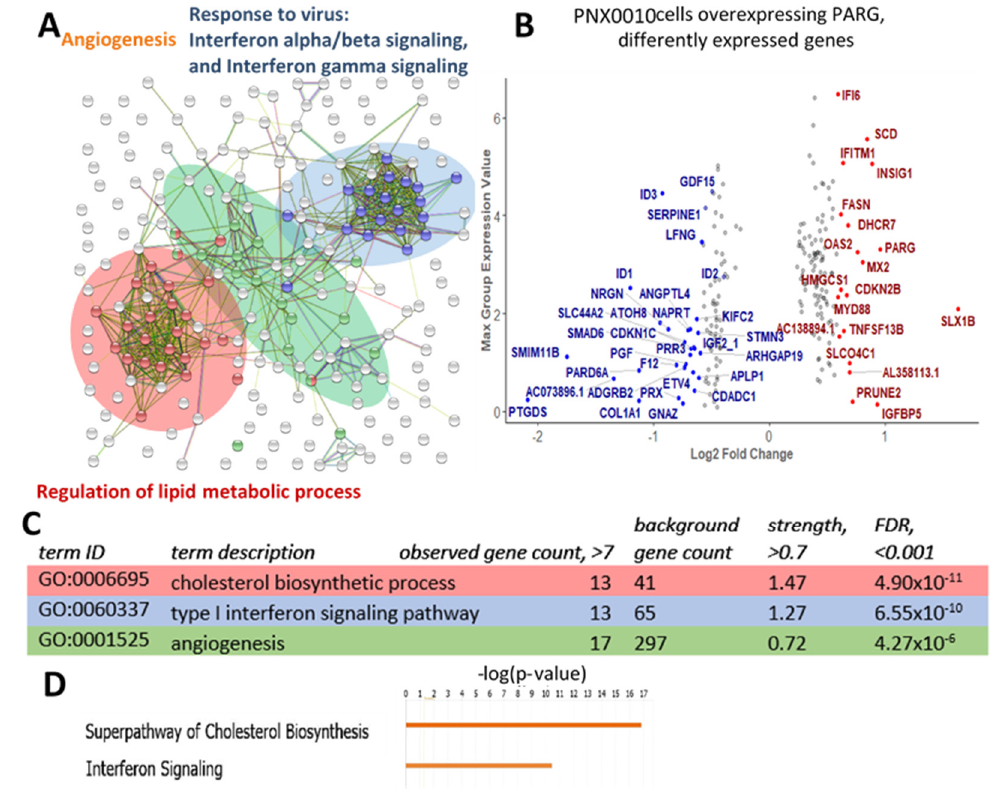
Figure 4. Lipid biosynthesis, interferon signaling, angiogenesis pathways, and several cancer-driving genes are affected under PARG overexpression in PNX0010 cell line. ( A ) Differently expressed genes with FDR-corrected p -value < 0.05 and maximum group expression value >1 were subjected to STRING analysis. Three main clusters were identified that are related to lipid metabolism, interferons signaling, and angiogenesis. ( B ) Differently expressed genes with FDR-corrected p -value < 0.05 and maximum expression value >1 are plotted and genes with fold change >1.5 are named. ( C ) GO terms for selected overrepresented pathways (for the whole list see (for the whole list see Figure S17). ( D ) IPA analysis shows activation of cholesterol biosynthesis and interferon signaling pathways.